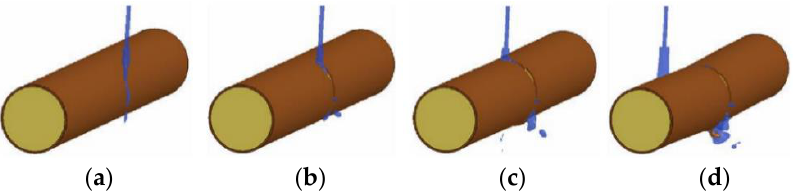
Figure 8. Simulation of jet cutting process: ( a ) breaking; ( b ) deepening; ( c ) crossing; ( d ) cutting off ([75], reproduced from the Ph.D. thesis “Study on anti -blocking device for no-till seeder with non- connect stalk cutting by ultra-high- pressure waterjet” with permission from the Author, 2 022).